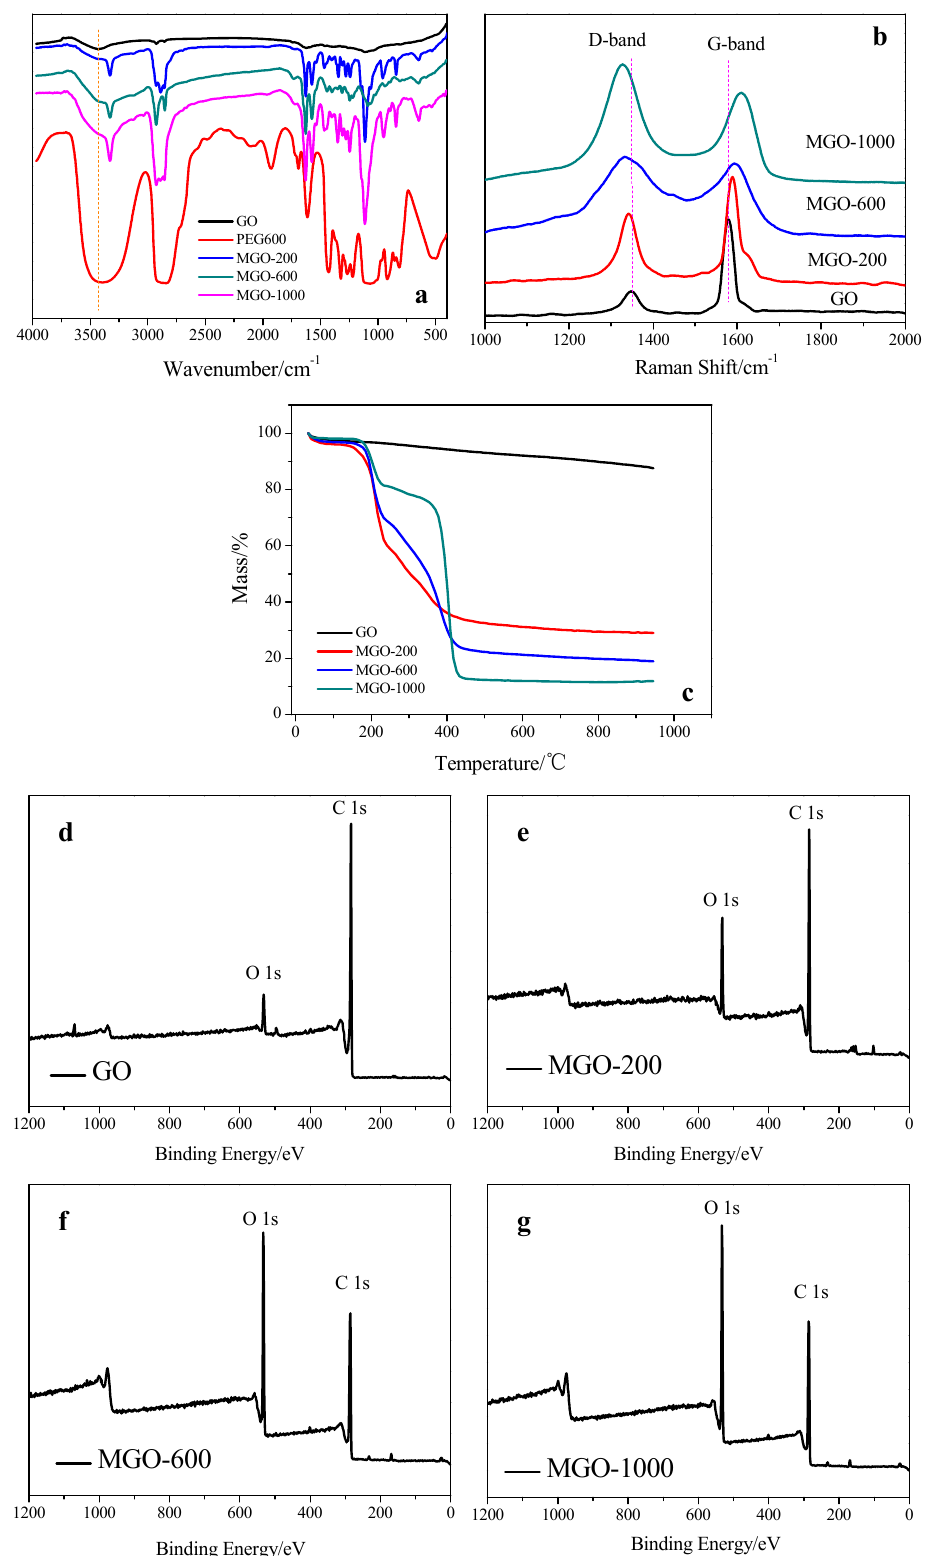
Figure 2. Structural characterizations of GO and MGO. ( a ) FTIR; ( b ) Raman spectra; ( c ) TGA; ( d – g ) XPS.